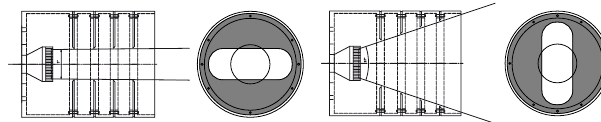
Figure 4. Design of stray light protection. Left: cut along spectral axis, right: cut along the spatial axis. The baffles have a length of 160mm and a diagonal of